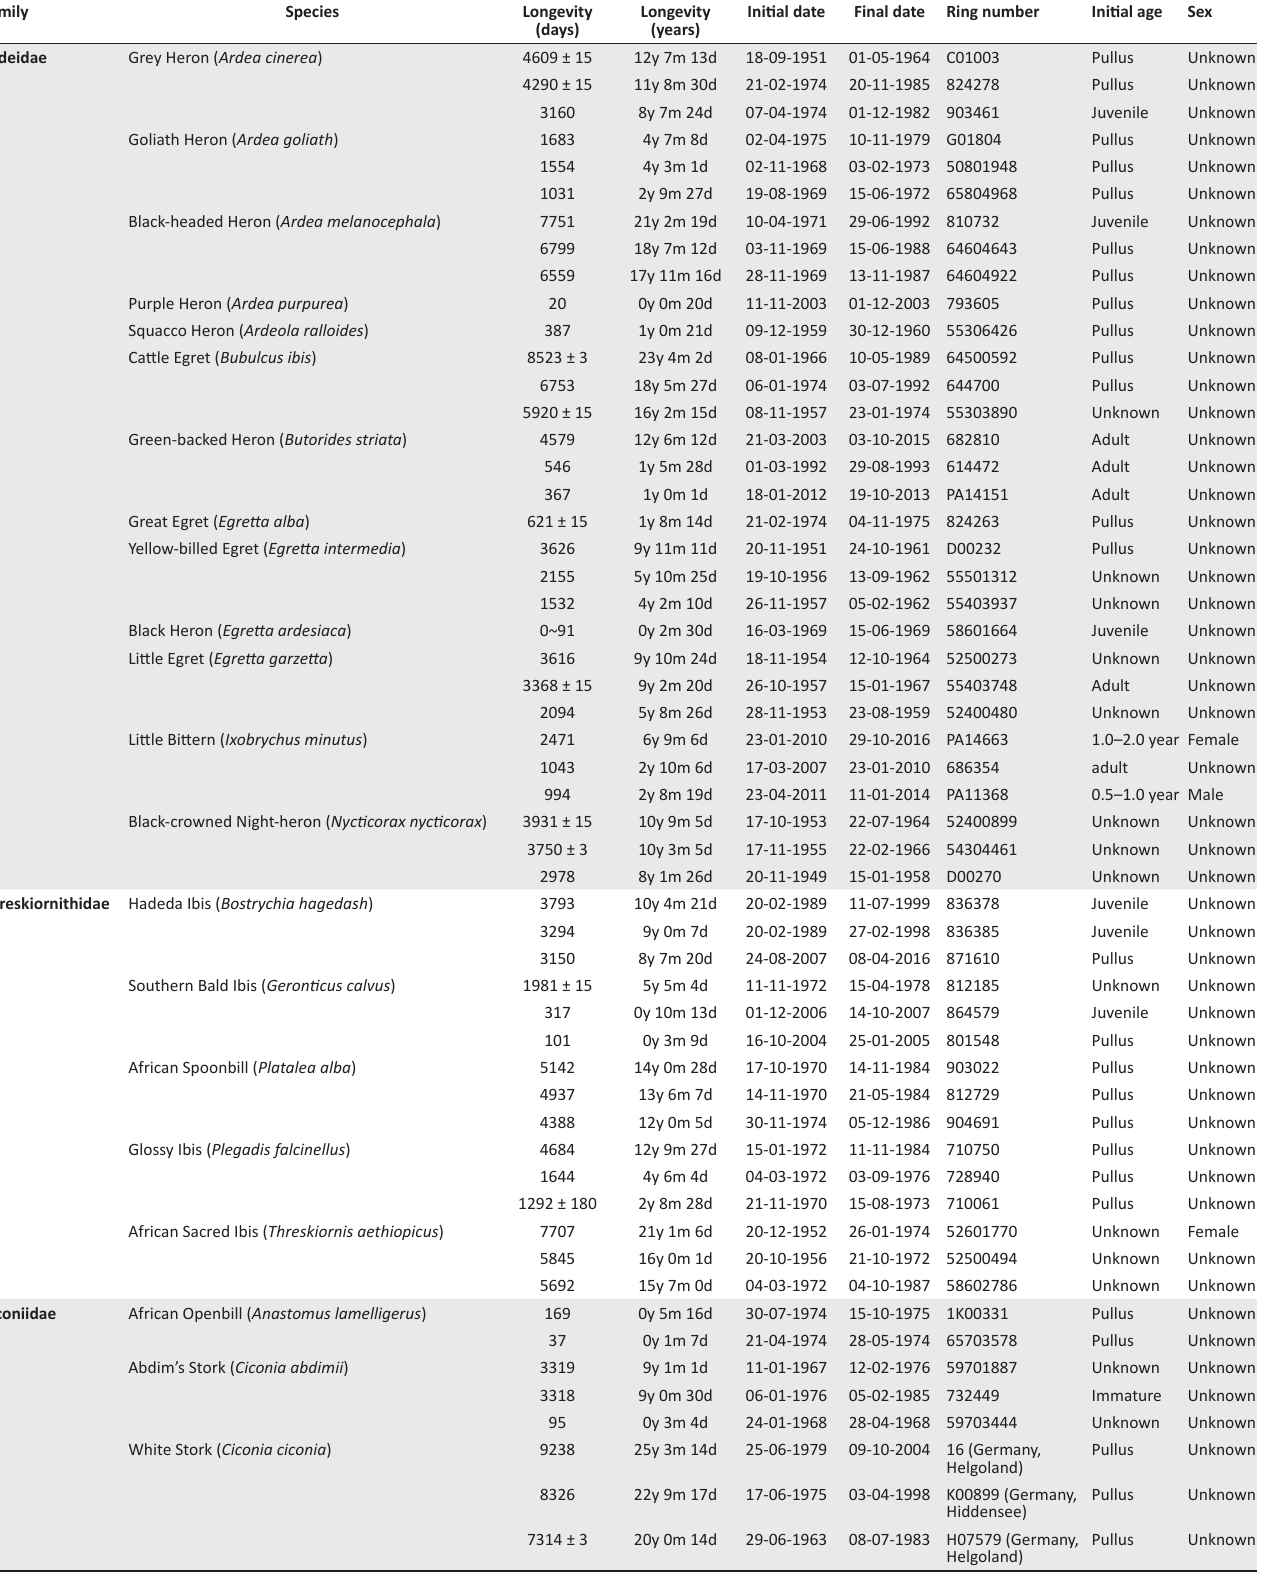
TABLE 1-A2: Top three longevity records of southern African Ardeidae, Threskiornithidae and Ciconiidae species from ringing records at the South African Ringing Scheme. Family